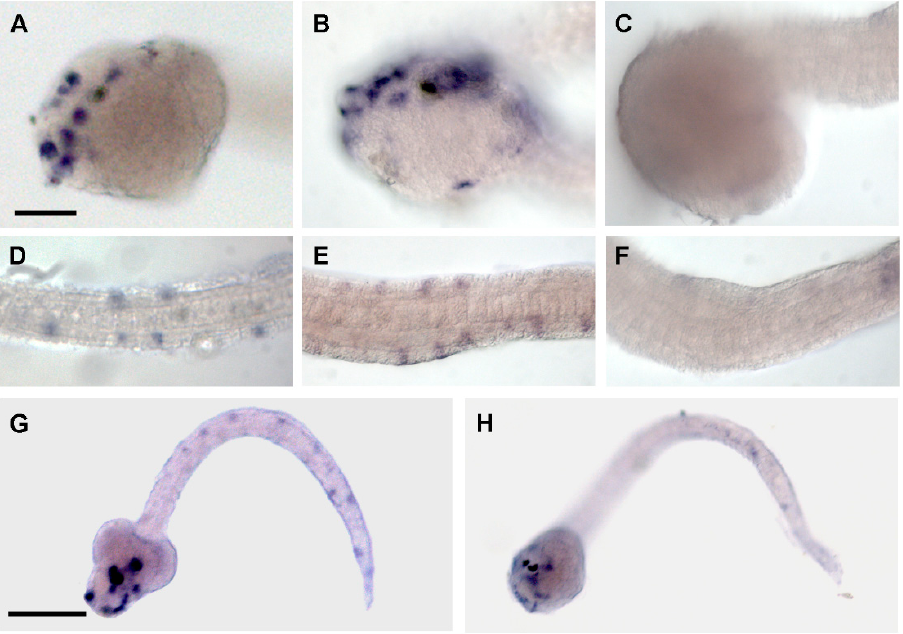
Figure 4. Whole mount in situ hybridization of control larvae ( A , B , D , E , G ) and larvae developed from embryos injected with PNA-a9 ( C , F , H ). ( A – F ) Anti- Ci-POU IV . ( G – H ) Anti- Ci-V-Glut probe.